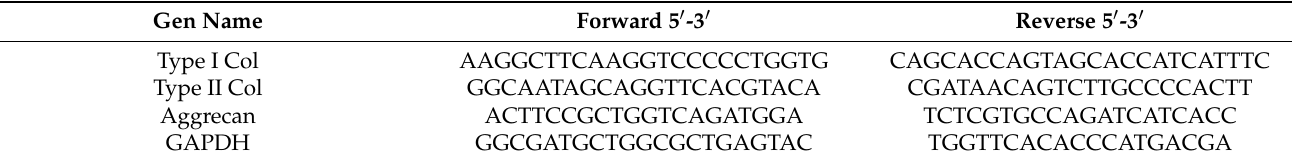
Table 1. Primer sequences used for real-time PCR